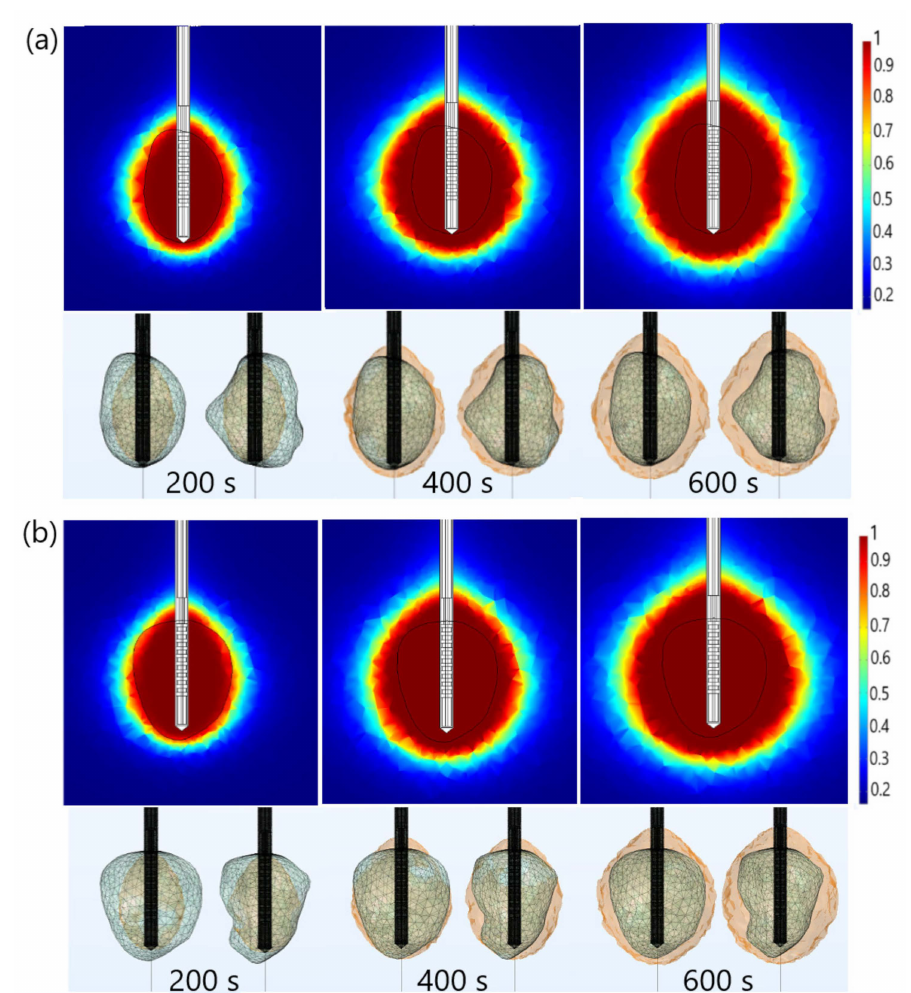
Figure 9. The time evolution of the necrotic tissue of tumors ( a ) 1.07 [51] and ( b ) 1.03 [51], after 200 s, 400 s, and 600 s MWA at a frequency of 2.45GHz. The upper figures show the necrotic tissue in the cut plane (x = 0). The lower figures show the front and back sides of the tumors (triangulated